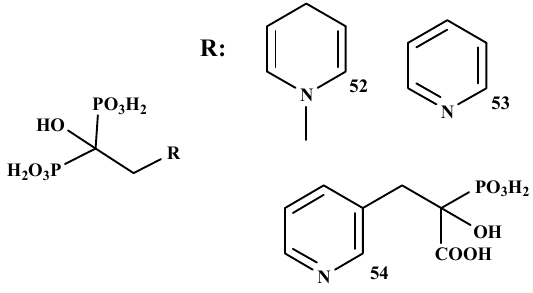
Figure 11. Structures of BP ‐ conjugates with anti ‐ prostate cancer activity 52–54